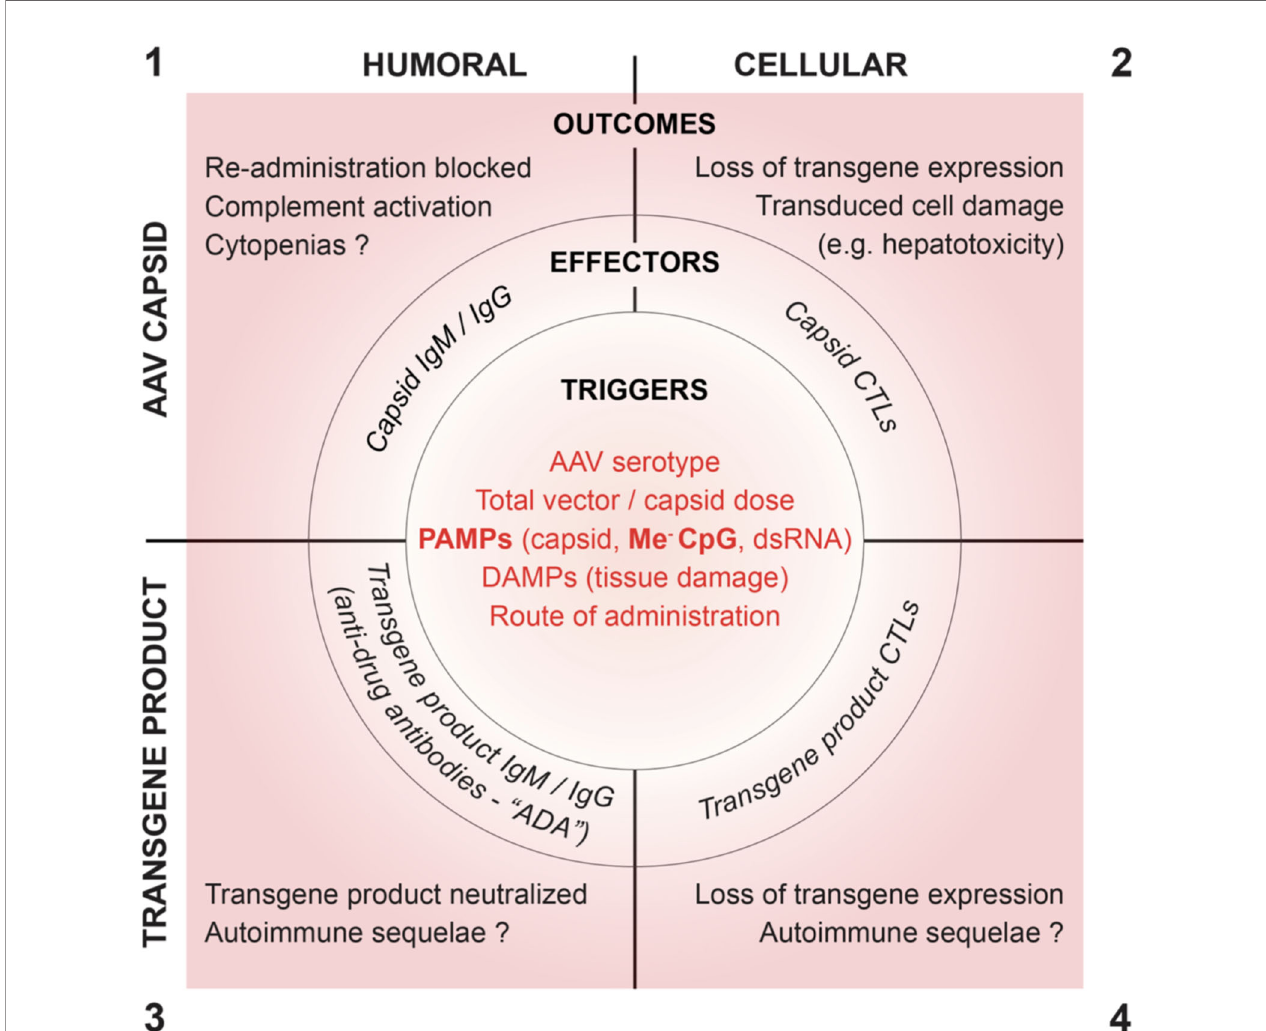
FIGURE 1 | Proposed root cause triggers, effector functions and clinical outcomes of humoral and cellular immune responses to AAV